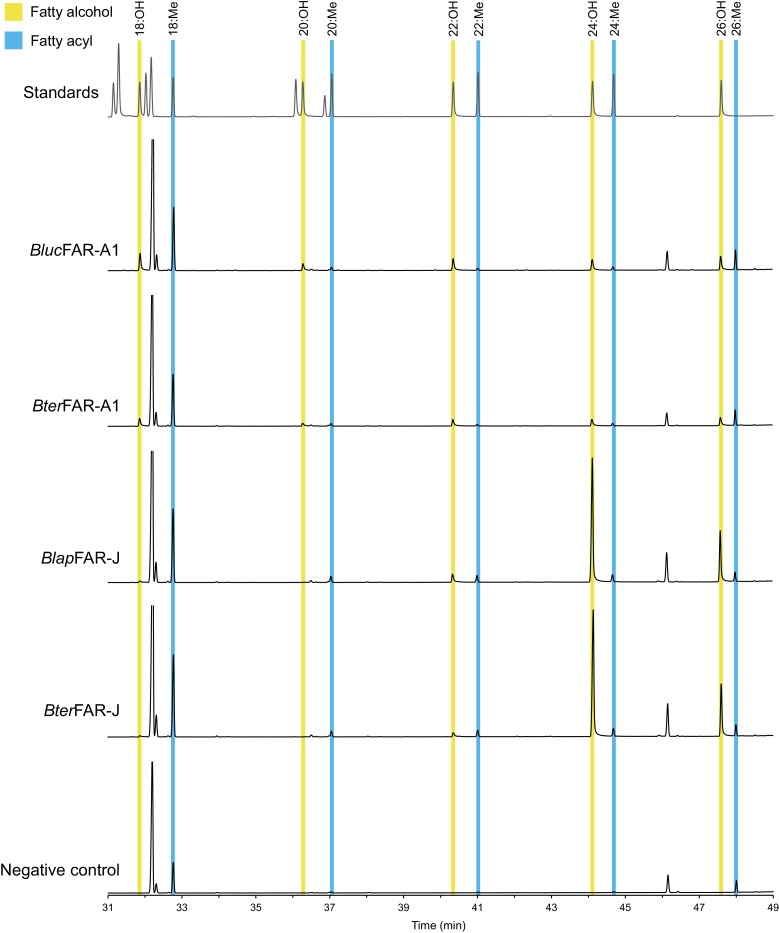
Fatty alcohol production in yeasts expressing bumble bee FARs specific for very long chain fatty acyls.The chromatogram traces show fatty alcohol and fatty acyl methyl ester profiles from lipid extracts of yeast expressing bumble bee FARs which are specific for very long chain fatty acyls (C20–C26), that is BlucFAR-A1, BterFAR-A1, BlapFAR-J, BterFAR-J.